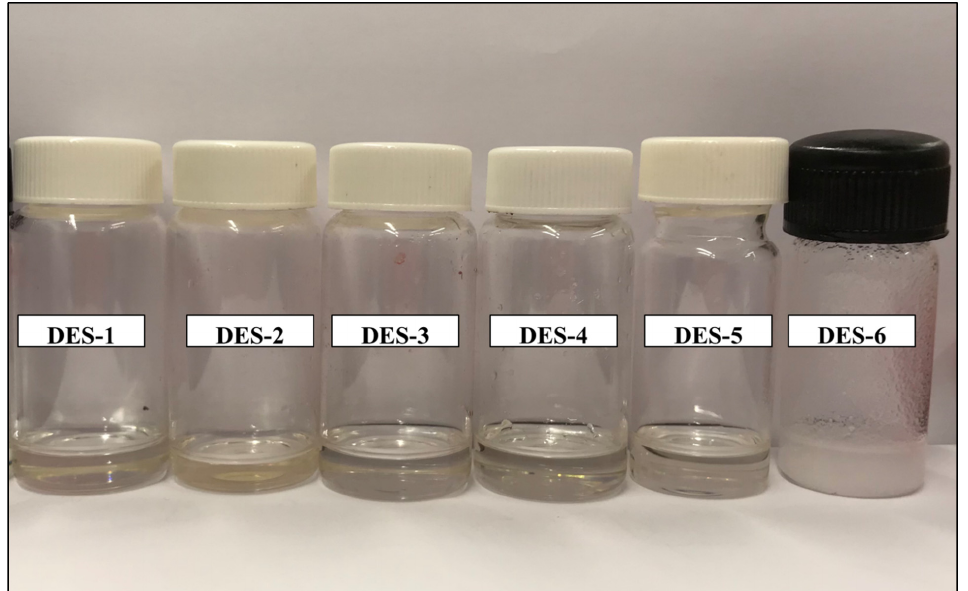
Figure 3. The prepared